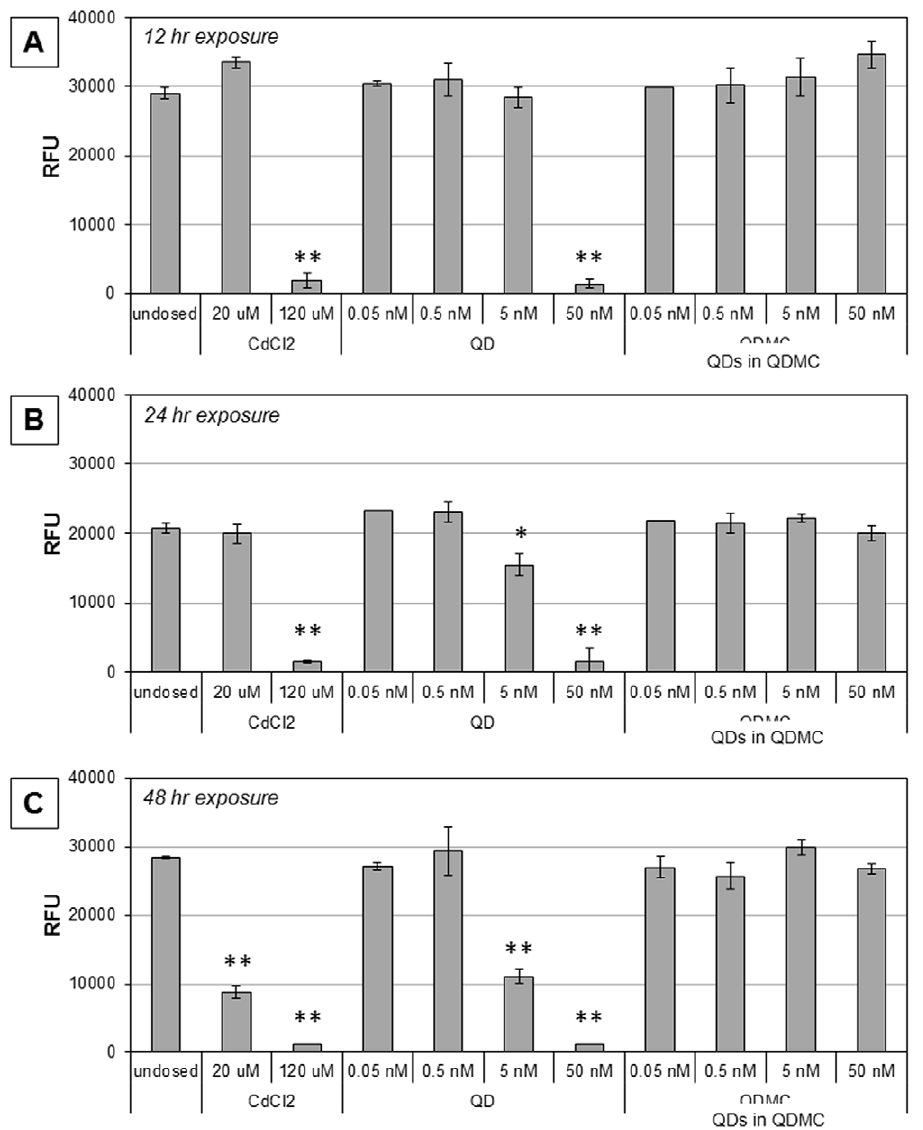
Figure 3. Differential cytotoxicity. Cytotoxicity was measured at A) 12 hrs, B) 24 hrs, and C) 48 hrs via fluorescence intensity of reduced resazurin. HDF cells at all time points were either exposed to 0.05–50 nM QDs or microencapsulated QDMCs, 20 or 120 m M cadmium chloride positive control, or unexposed. * p-val , 0.05, ** p-val , 0.001. Note: the QDMC concentrations refer to the total concentration of QDs contained in the microcapsules.